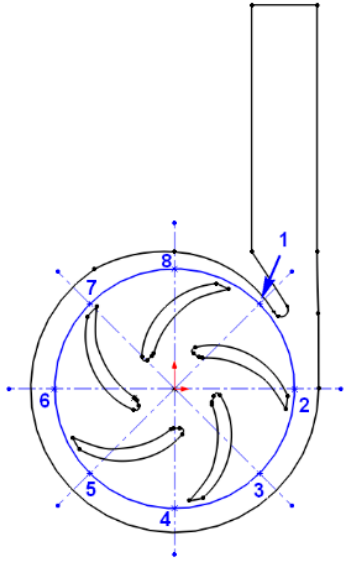
Figure 16. Distribution of the circumferential monitoring